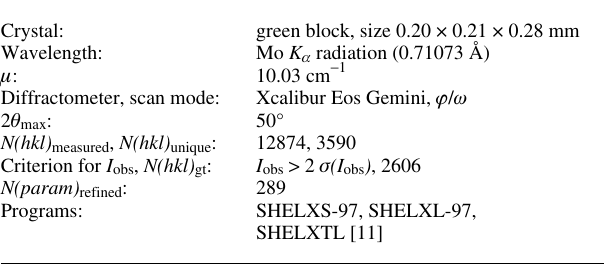
Table 1. Data collection and handling.